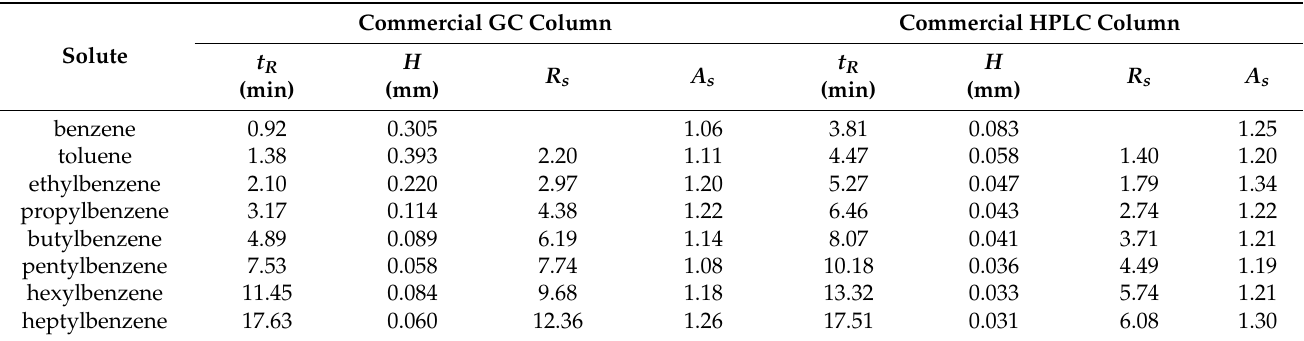
Table 4. Peak parameters for the separation of the alkylbenzene mixture using commercial GC and HPLC columns expressed in terms of the t R , H , R s , and A s under the optimal